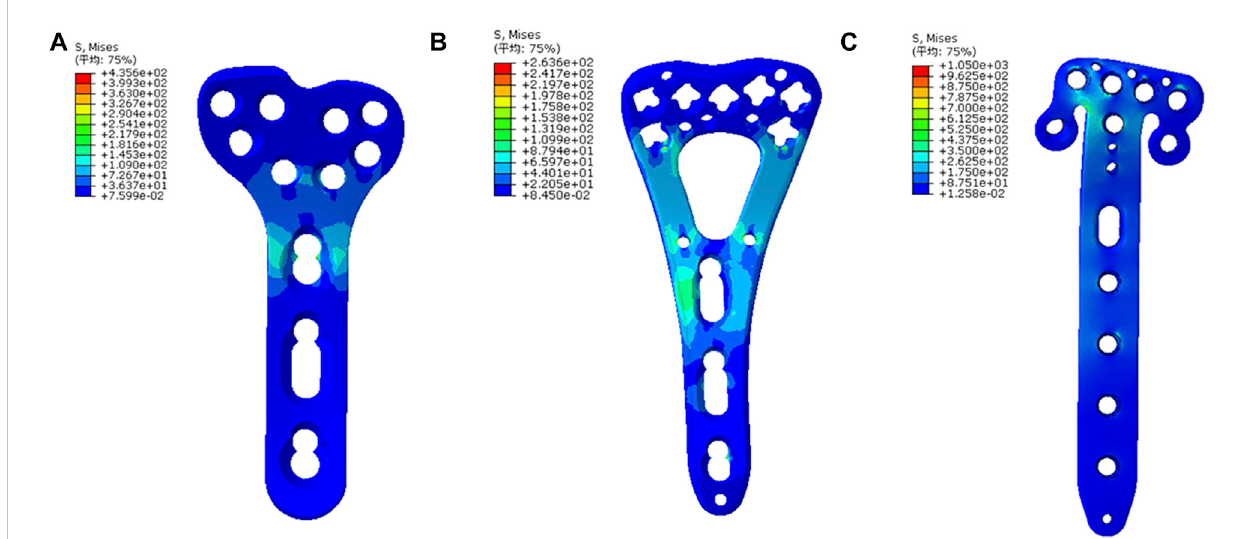
The von Mises stress nephogram of implants and the stresses were mainly concentrated at the junction of plate head and body. (A) The stress nephogramintheTplate; (B) ThenephogramintheVplateandthepeakstresswaslowerthanthatintheTplate. (C) Thenephograminthe π plateandthe peak stress was higher than those in the other two